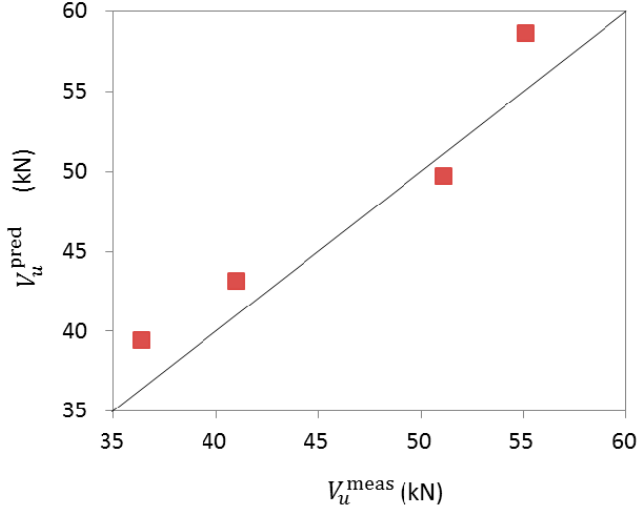
Figure 15. Comparison of the predicted and measured concrete breakout shear resistance.